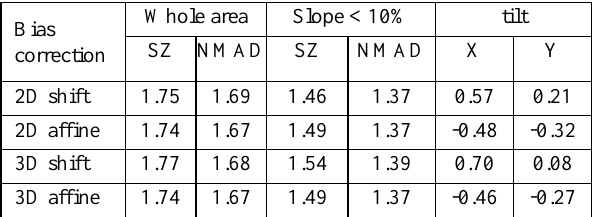
Table 6. Discrepancies of WorldView-2 orientation at 13 to 15